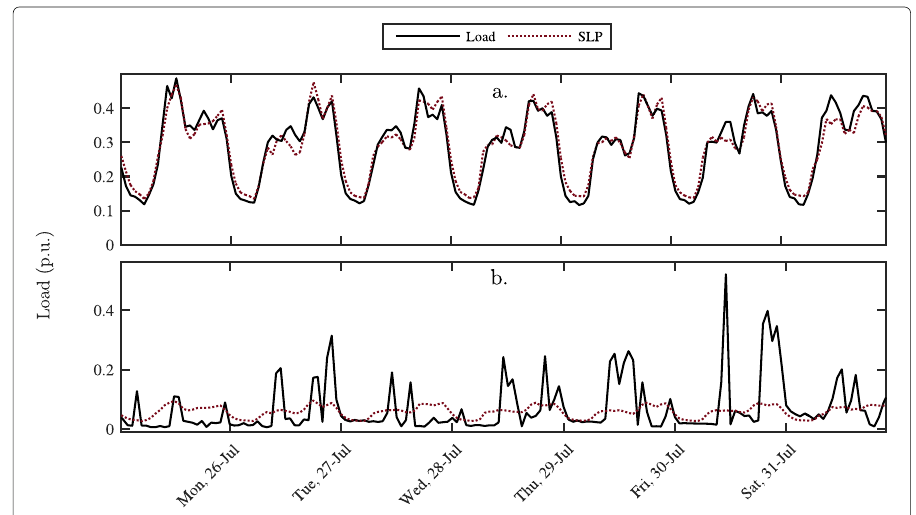
Fig. 1 Load and SLP of an aggregation of 400 households ( a ) in comparison to a single home ( b ). Aggregated load curve is substantially smoother and follows a regular